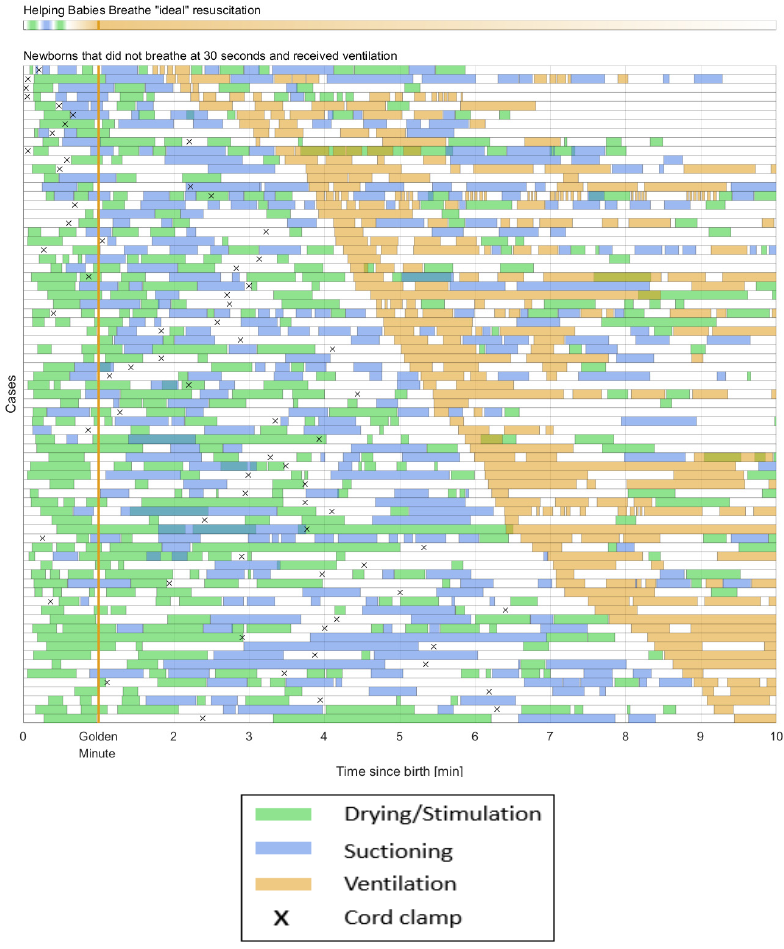
Figure 3. Resuscitation care practices among newborns not breathing well by 30 s after birth who received bag-mask ventilation (BMV; n = 73). The Helping Babies Breathe (HBB) “ideal” resuscitation demonstrates the practices recommended by HBB for a non-breathing baby, starting with drying shortly after birth, followed by brief suctioning (if secretions are noted), and returning to stimulation before initiating BMV by one minute after birth. Below, each row represents an individual newborn who received BMV.